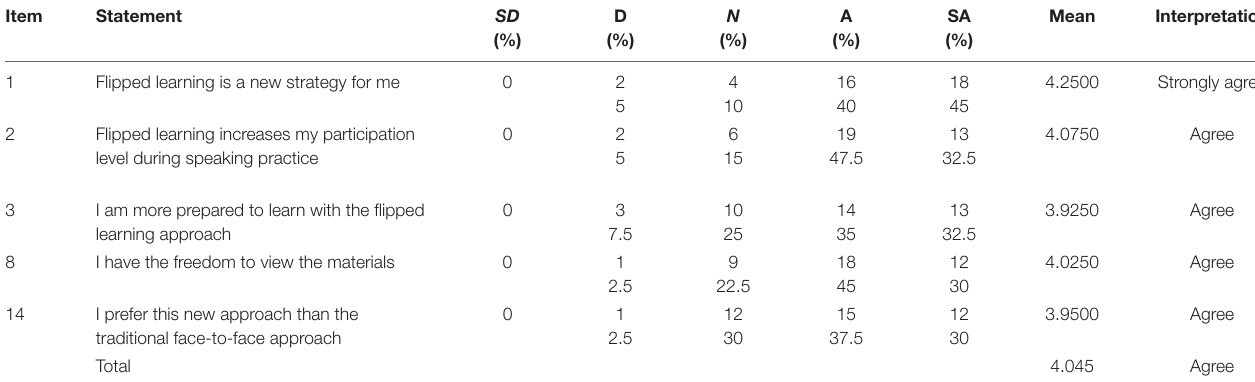
TABLE 4 | Mean score and standard deviation of participation.